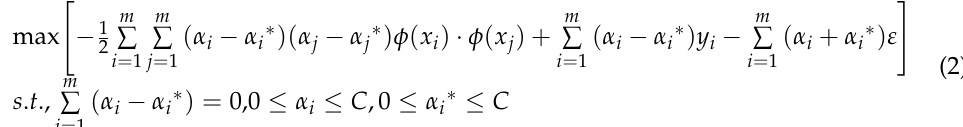
Figure 6. Principle of support vector machine.